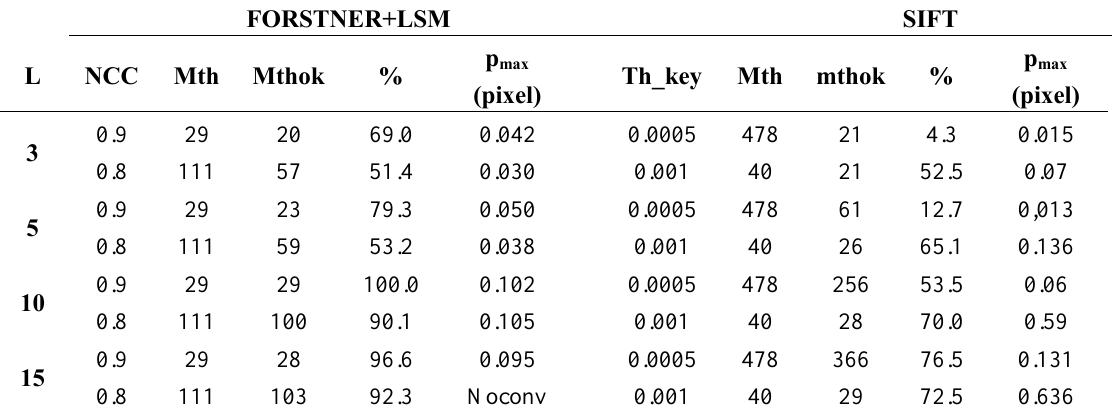
Table 5. The Villareggia test 1. The experimental results of the examined operators, in relation to the NCC , Th_key and L parameters. FORSTNER+LSM